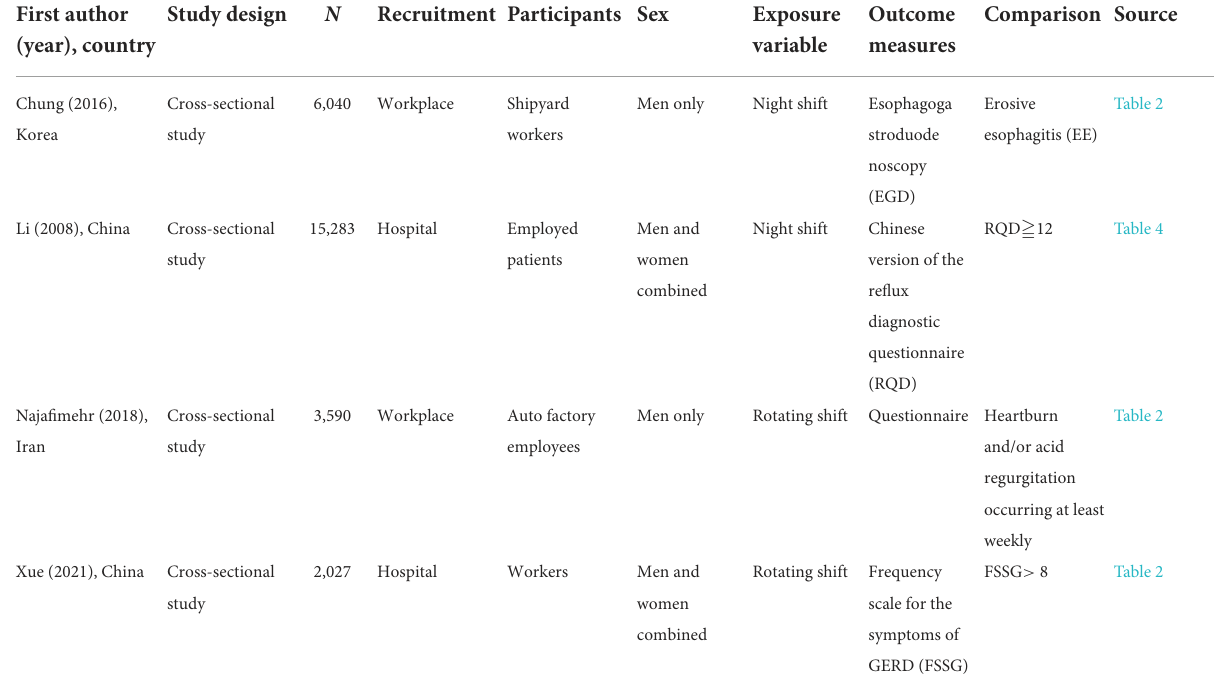
TABLE 1 Studies included in the meta-analysis ( N =